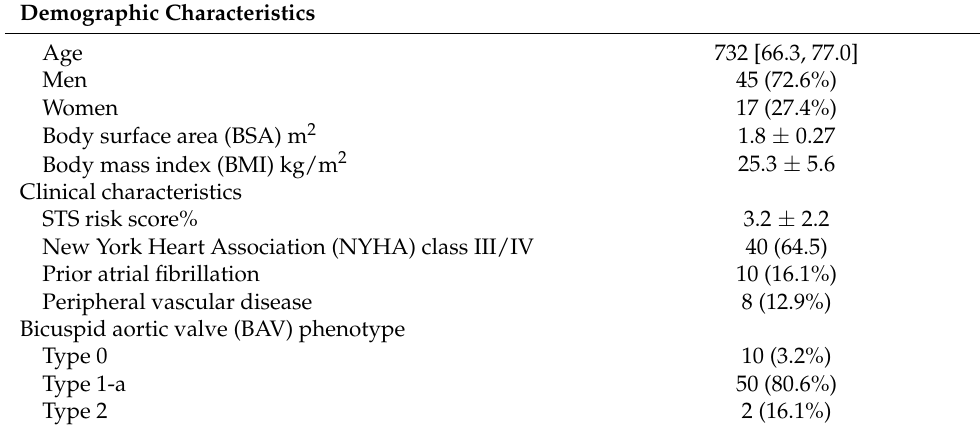
Table 1. Patients’ baseline